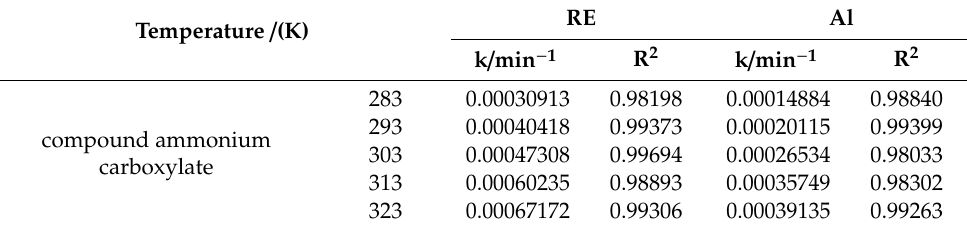
Table 4. Internal di ff usion apparent rate constant and correlation coe ffi cient values.